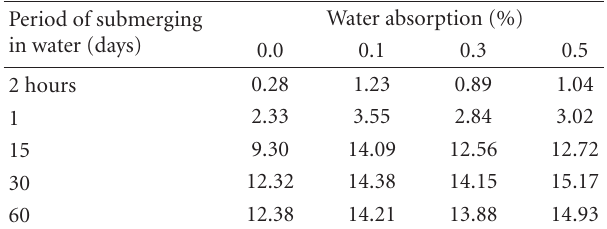
Figure 2: Graph water absorption of counterrotating twin-screw extruder.